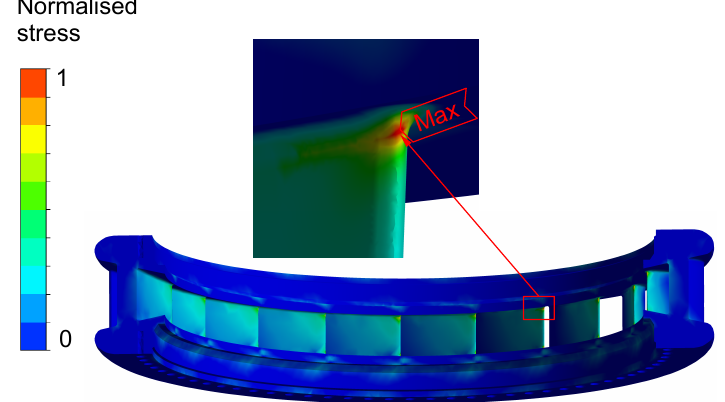
Figure 19. The maximum stress of the stay ring. The head cover is only supported by the stay ring in the axial direction but has a large area facing the high pressure water. The stiffener plates are welded between the inner and outer head cover to increase the stiffness and effectively reduce the deformation of the head cover caused by the pressure; however, different shaped openings and holes are made in the stiffener plates for installing various pipes such as pressure balance pipes, cooling water pipes and pressure measurement pipes. The normalized stress distribution of the head cove relative to its maximum stress value is shown in Figure 20, which shows that the hot spots of head cover during load rejection appear on the different shaped openings of the stiffener plates and the maximum stress occurs on the bottom-right side of the circular